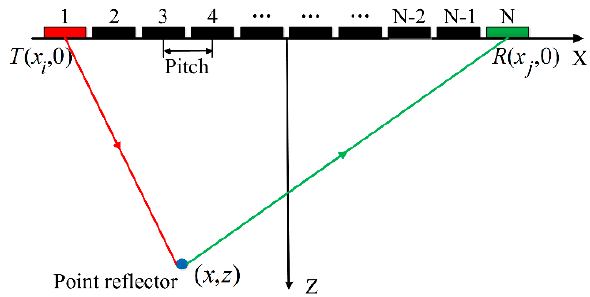
Figure 2. Schematic diagram of total focus method (TFM).